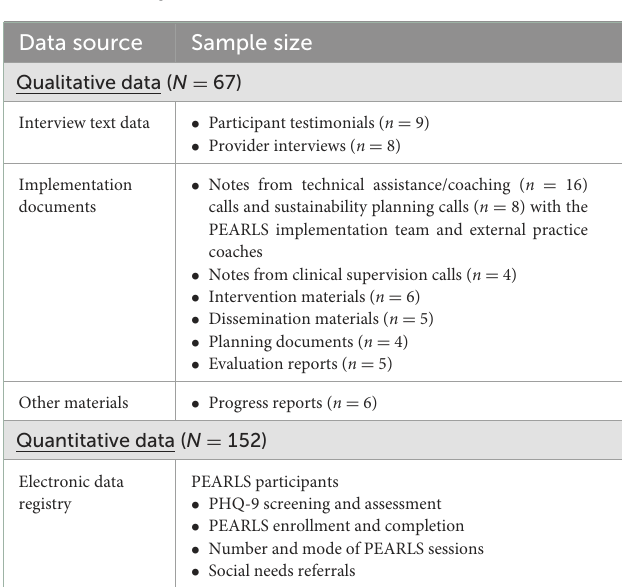
TABLE 1 Case study data